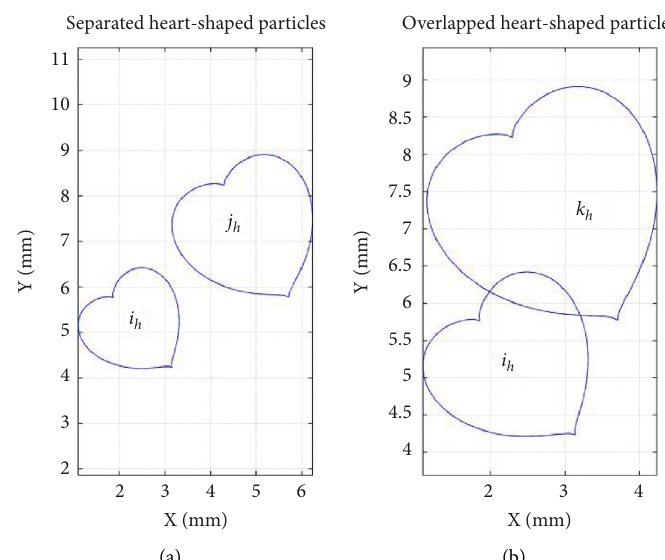
Figure 6: Two kinds of relative positions of heart-shaped particles. (a) Separated heart-shaped particles. (b) Overlapped heart-shaped particles.